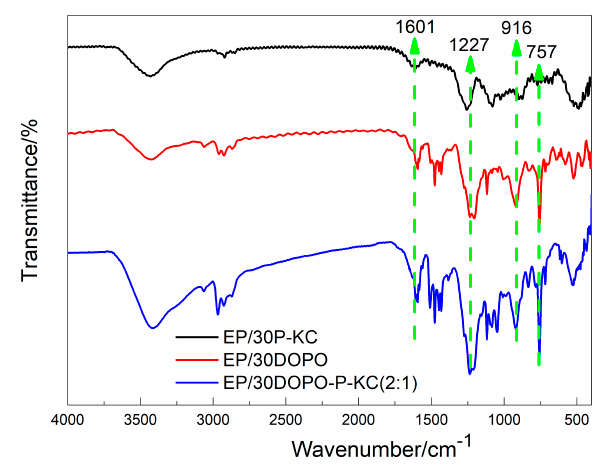
Figure 7. FTIR spectra of char from EP and FR-EP.